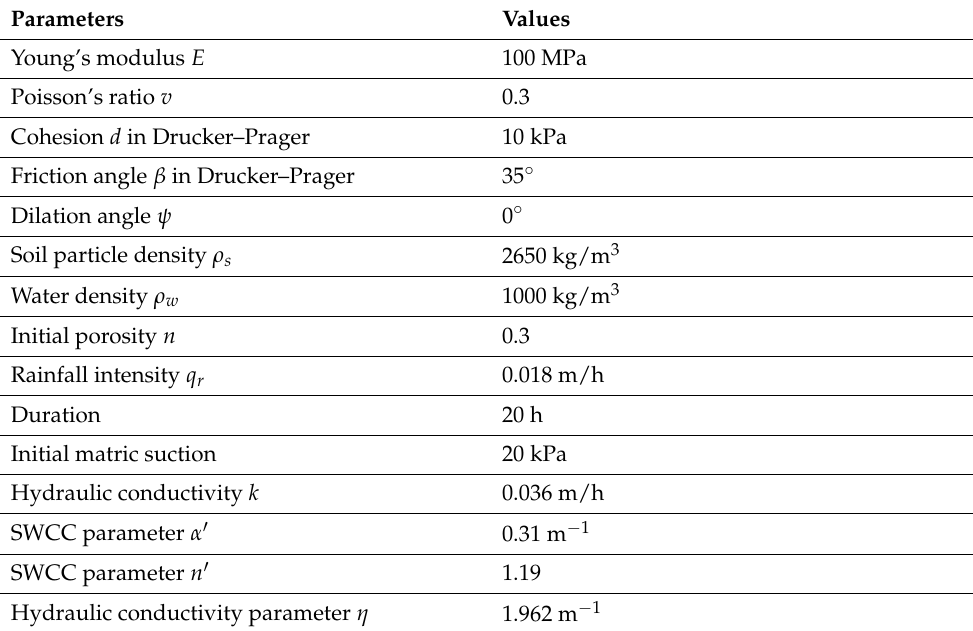
Table 1. Parameters used in the simulation of rainfall-induced